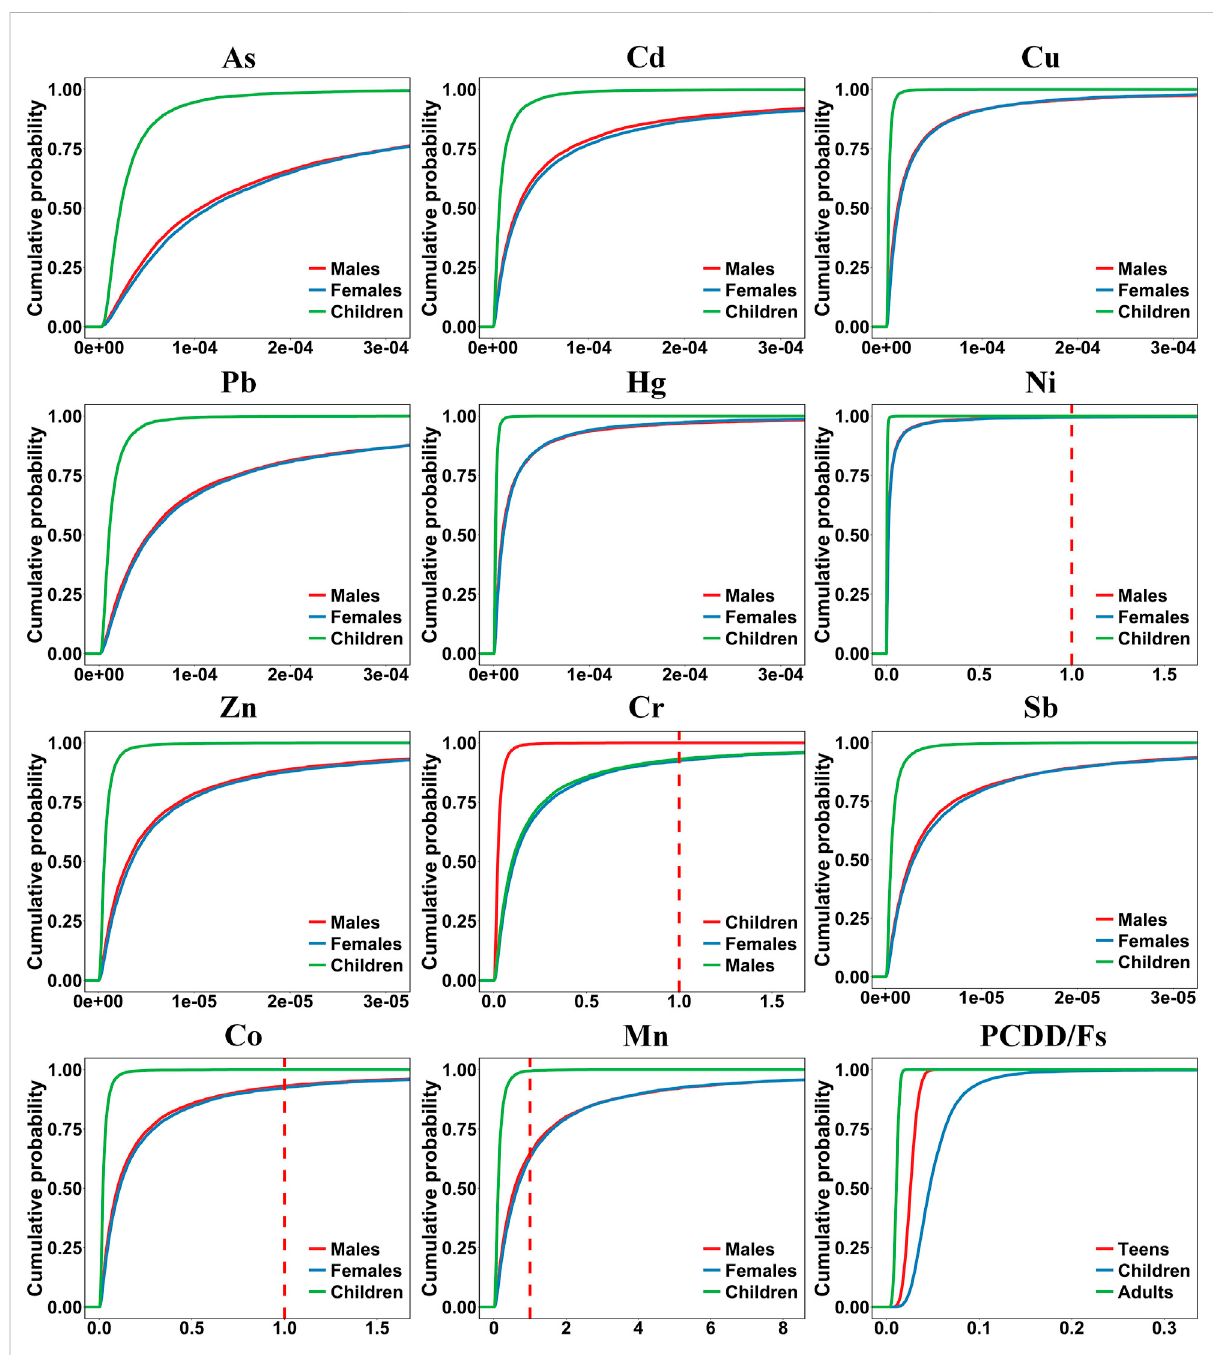
FIGURE 11 Cumulative probabilities of the total non-carcinogenic risk for different population groups (Note: dotted lines represent acceptable levels).